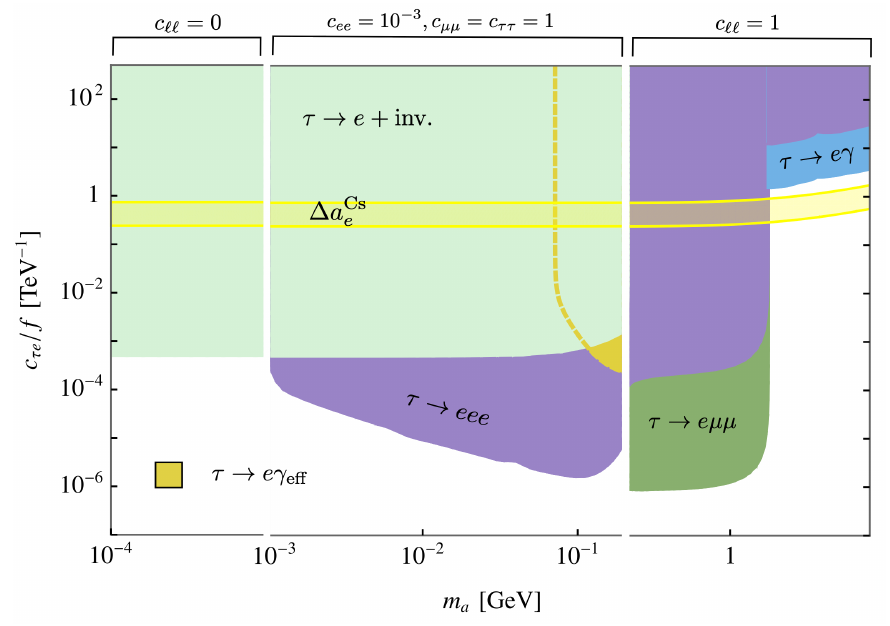
Figure 46 . Bounds on ALP mediated flavor off-diagonal transitions between taus and electrons p with c | [ k E ] 31 | 2 + | [ k e ] 31 | 2 , assuming universal ALP couplings to leptons as indicated above τe ≡ the plot for the different ALP mass